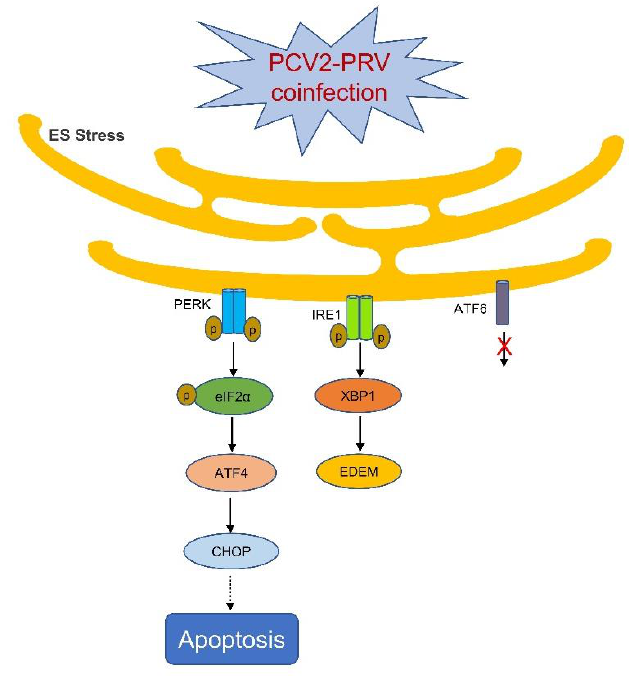
Figure 9. Schematic diagram of PCV2 and PRV coinfection on the activation of ERS. Arrow, confirmed; dashed arrow, needs to be clarified; ×, unactivated pathway.